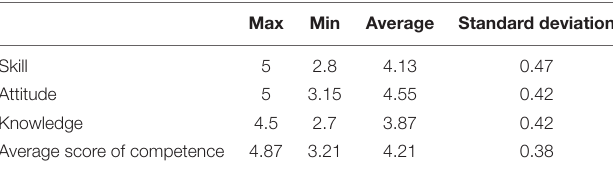
TABLE 6 | Current competence of psychological hotline